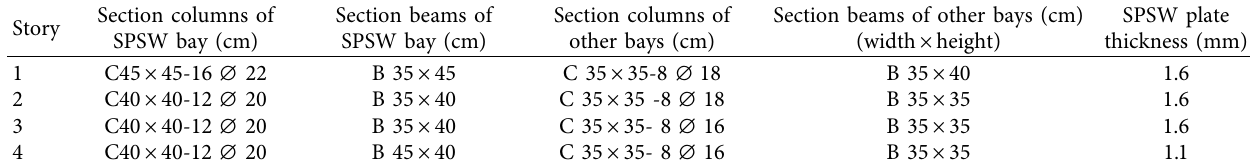
Table 2: Properties of designed beams, columns, and steel plate shear walls of 4-story model (Figure 3(b)).